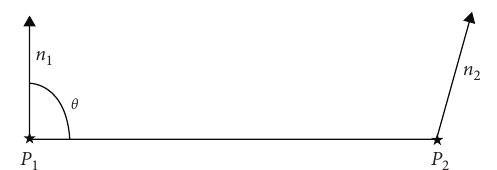
Figure 3: The included angle between the line segment and the normal vector of the